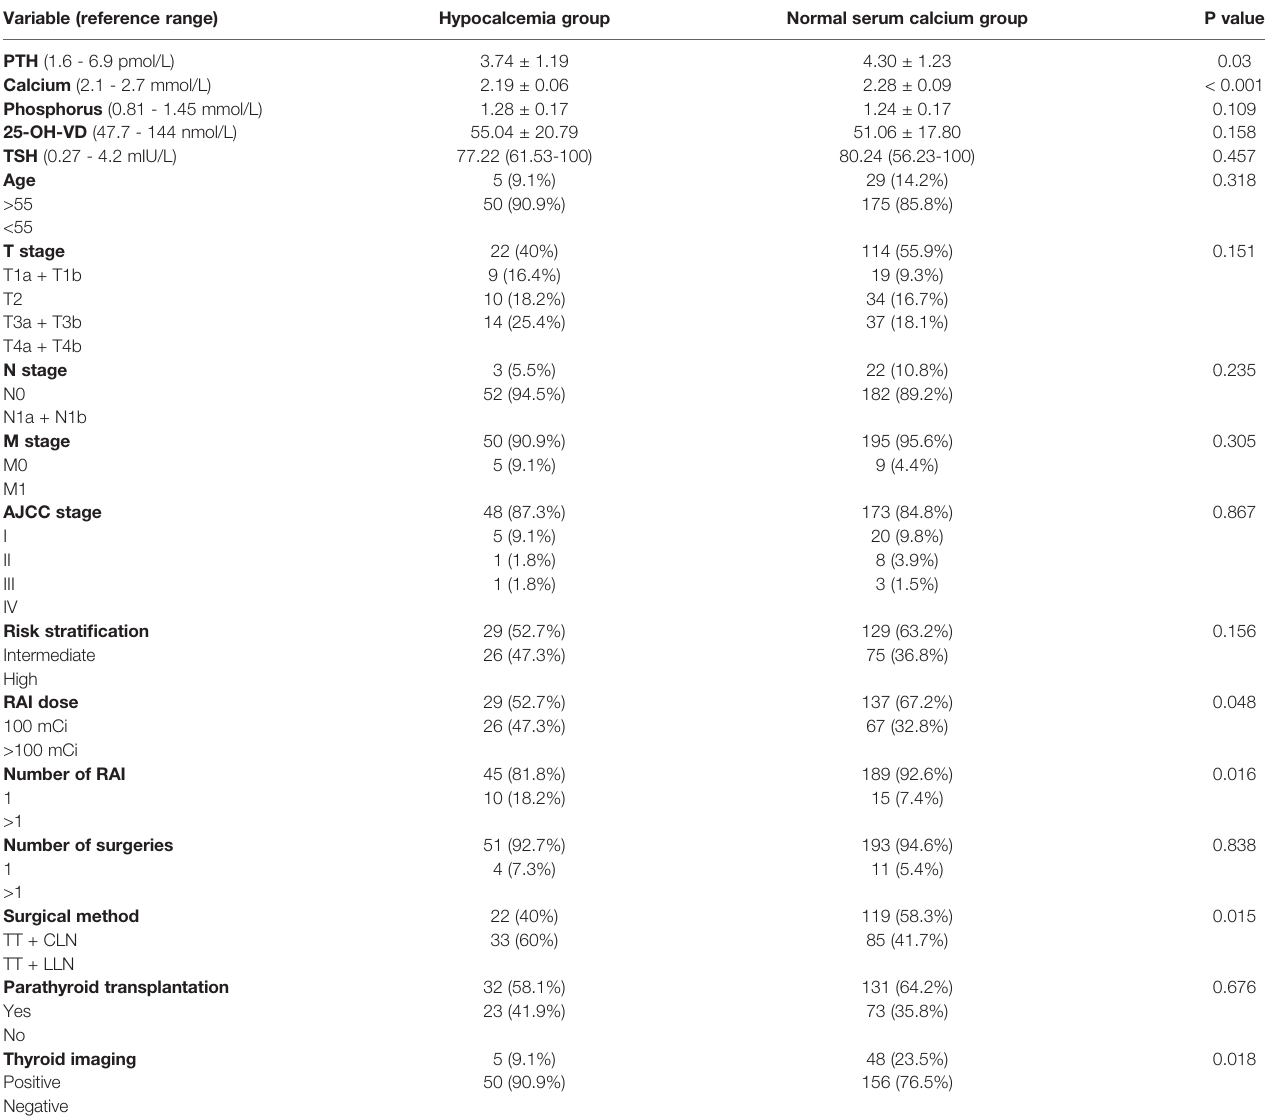
TABLE 4 | Comparison of baseline related parameters between hypocalcemia group and normal serum calcium group at fi ve days post-RAI. Variable (reference range)